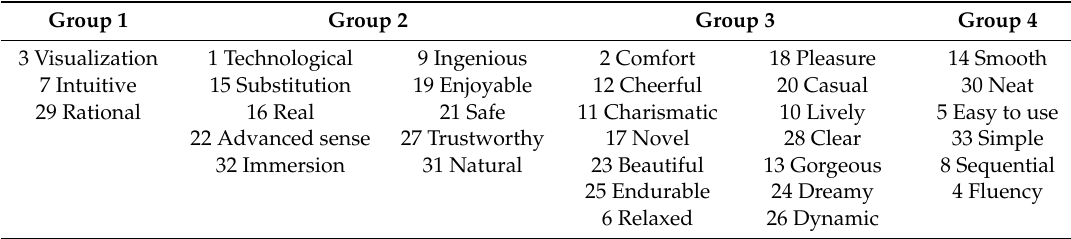
Table 5. Criterion word group.